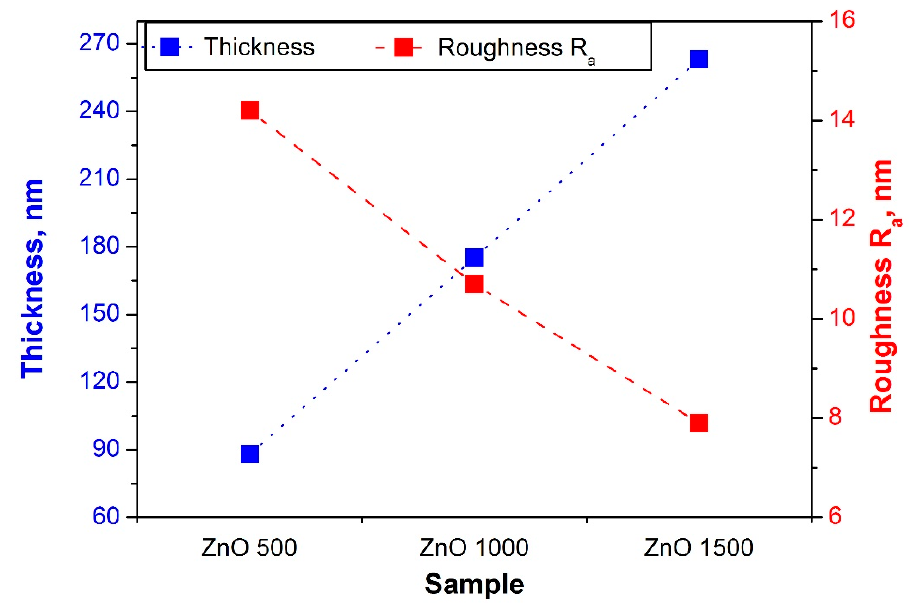
Figure 4. Thickness and roughness values of samples with a ZnO layer.